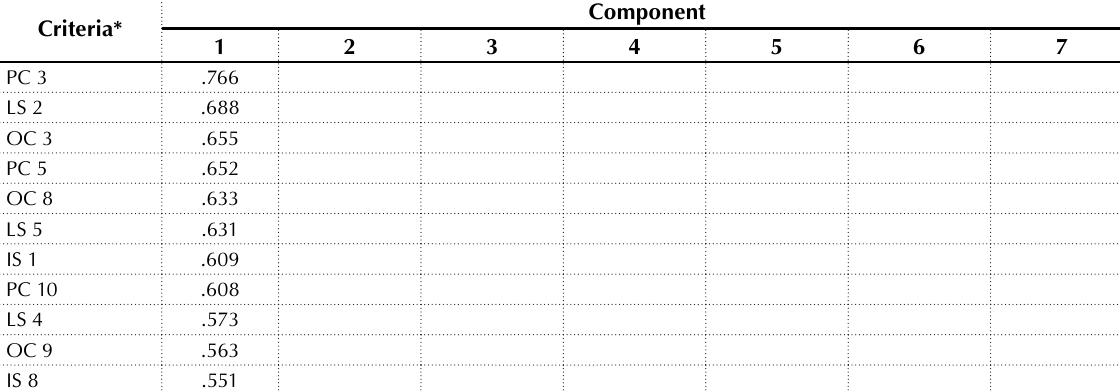
Table 6. Rotated Component Matrix: Sub-factors extracted from Factor 1